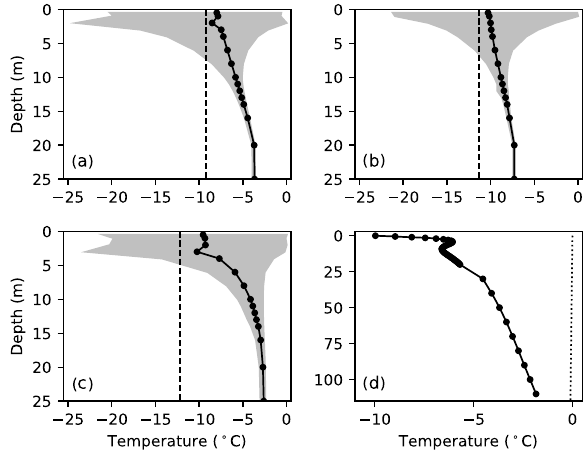
Figure 4. Ice temperature measurements from four ice boreholes. (a, b, c) Ice temperature measurements from the 25m deep bore- holes at site 1, 2, and 3, respectively. The black dots show the mean annual ice temperatures over the period of 2010–2011. The shaded areas show the yearly fluctuation range of the ice temperature. The dashed lines indicate the mean annual air temperature. (d) Measured ice temperatures in the deep borehole. The dotted line indicates the pressure melting point (PMP) as a function of